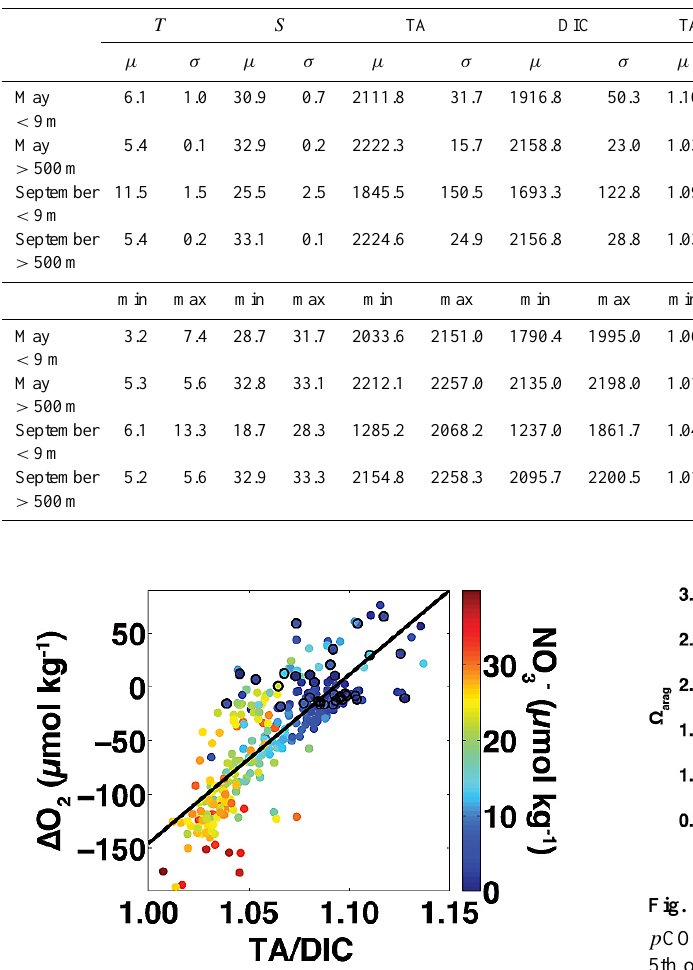
Fig. 4. Measured O 2 minus the saturation O 2 value ( 1 O 2 ; µmolkg − 1 ) as a function of TA/DIC ratio and NO − tion (µmolkg − 1 ). A linear fit between 1 O 2 and TA/DIC ratio is shown ( 1 O 2 = 1569 × TA/DIC+ − 1714; r 2 = 0 . 65). Surface data ( < 9m) are highlighted using bold circles.